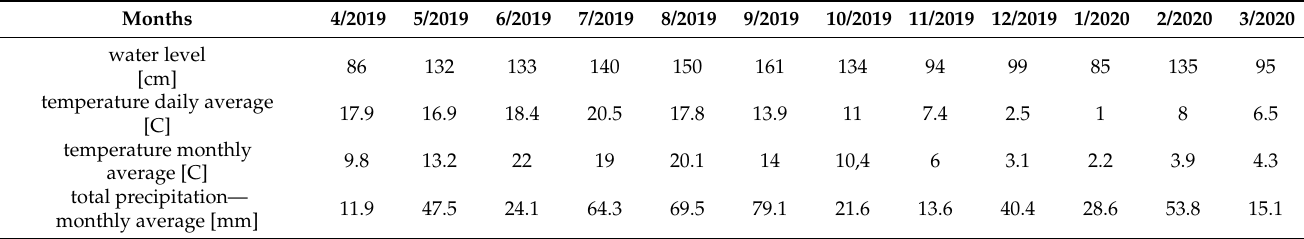
Table 1. Water level [mm], temperature: daily and monthy average [C], total precipitation [mm] of Utrata river in